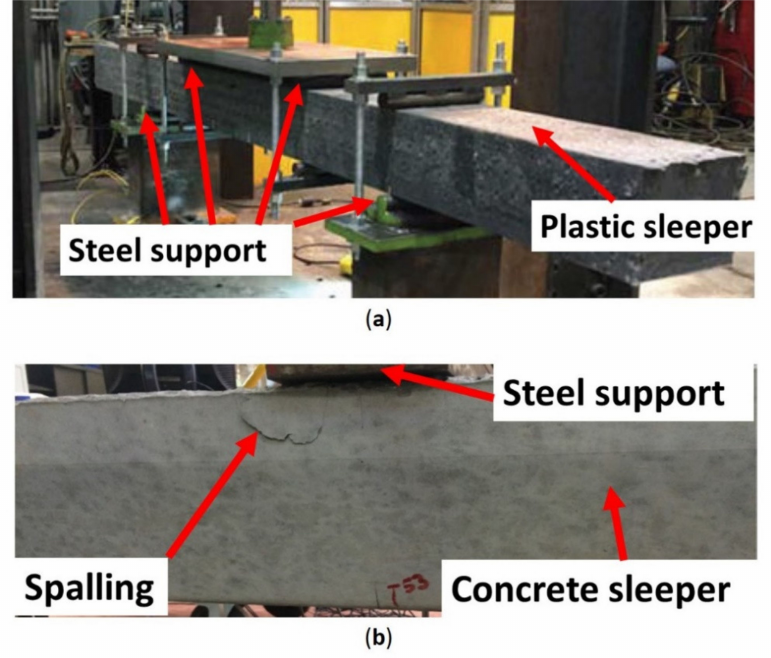
Figure 2. ( a ) Four-point bending test of a plastic sleeper without resilient pads [25]. ( b ) Spalling of the concrete surface under a steel plate